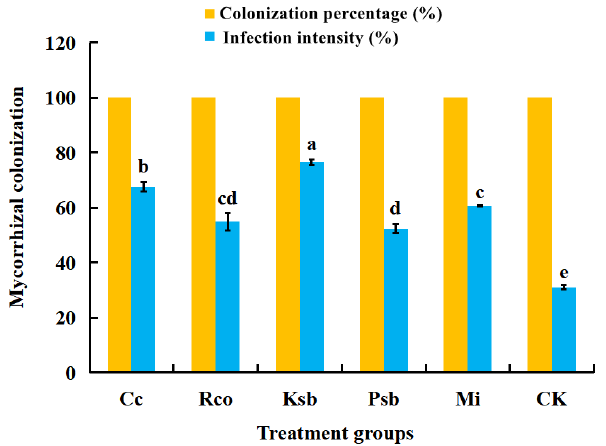
Figure 1. Effects of different microbial inocula on mycorrhizal colonization in the F. taipaiensis root system. The values are means ± standard deviation of 3 replicates (50 root segments per replicate) randomly selected from each treatment. Different lowercase letters indicate significant differences ( p < 0.05) in the infection intensity among the six treatments. Cc: Claroideoglomus claroideum treatment group, about 1360 C. claroideum spores for each container; Rco: Racocetra coralloidea treatment group, about 1430 R. coralloidea spores for each container; Ksb: potassium solubilizing bacteria treatment group, 35 g Bacillus mucilaginosus inoculum for each container; Psb: phosphorus solubilizing bacteria treatment group, 35 g Bacillus megaterium inoculum for each container; Mi: mixed treatment group with mixed inoculum of C. claroideum , R. coralloidea , B. mucilaginosus , and B. megaterium , the appli- cation amount of each microbial inoculum was 1/4 of the former 4 groups; CK: control group, no microbial inocula were used. Table 1. Effects of different microbial inocula on the photosynthetic pigment content of the F. taipaien- sis leaves (fresh weight).